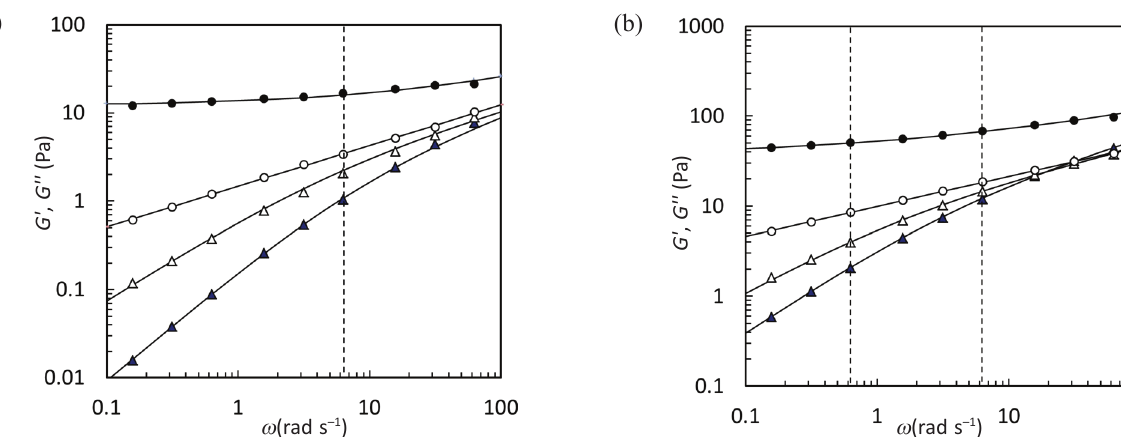
Fig. 2 – Mechanical spectra of systems 1.0 %wt (a) and 1.8 %wt (b) in the initial and asymptotic conditions. Symbols: for t → 0 (triangles), for t → ∞ (circles); black (G'), white (G''). Lines in the figures represent the best fits of the experimental data obtained with the FB model (Eqs. (2’) and (2’’)). The dotted lines individuate the frequencies used in the time series depicted in Fig. 1.